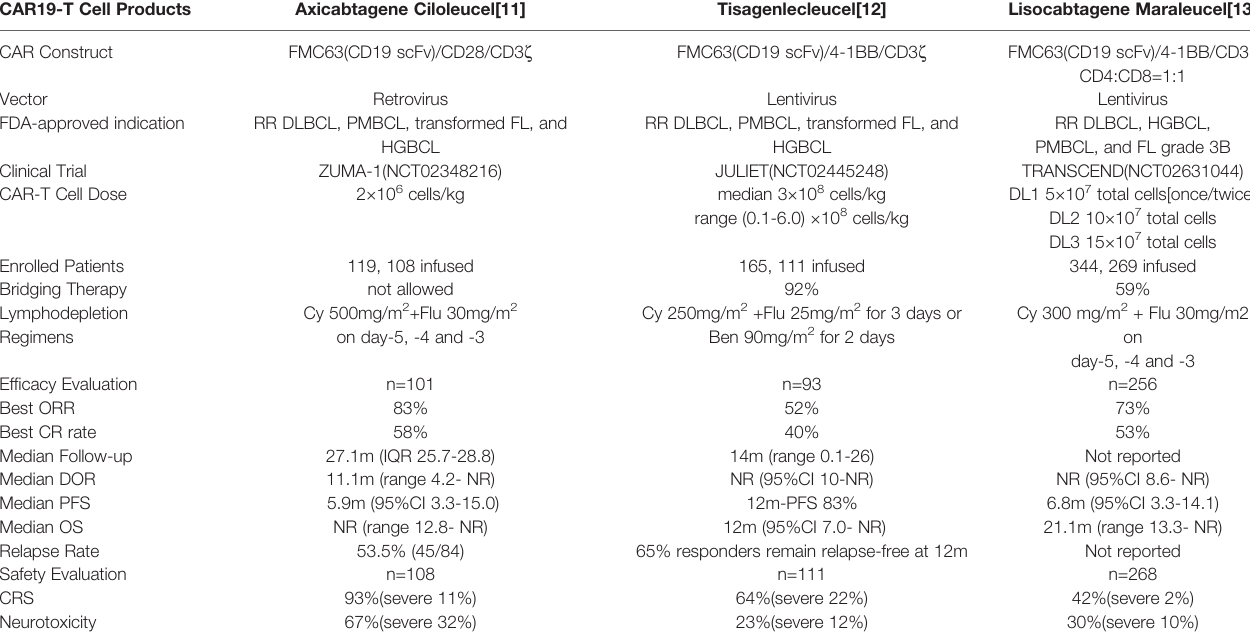
TABLE 1 | Representative CAR19-T cell products in B-cell lymphoma. CAR19-T Cell